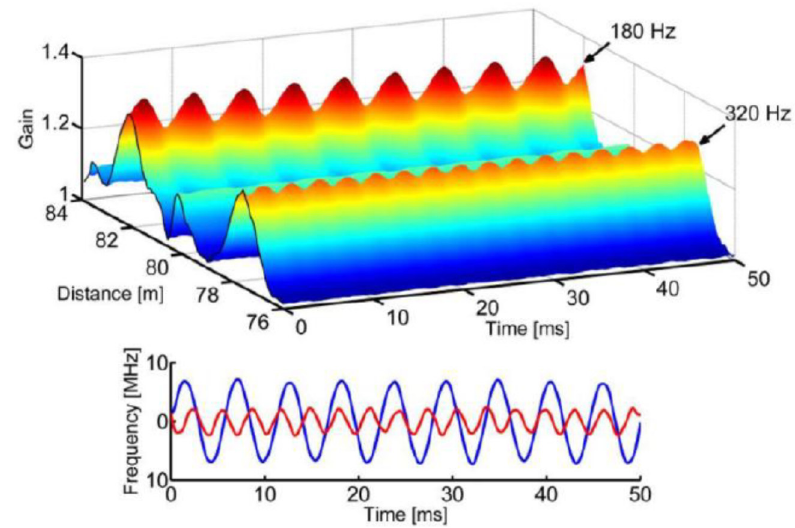
Figure 9. ( Top ) Brillouin gain variations acquired along an 85-m long fiber with two sections subjected to dynamic strain. ( Bottom ) Corresponding BFS changes in the two positions [55].